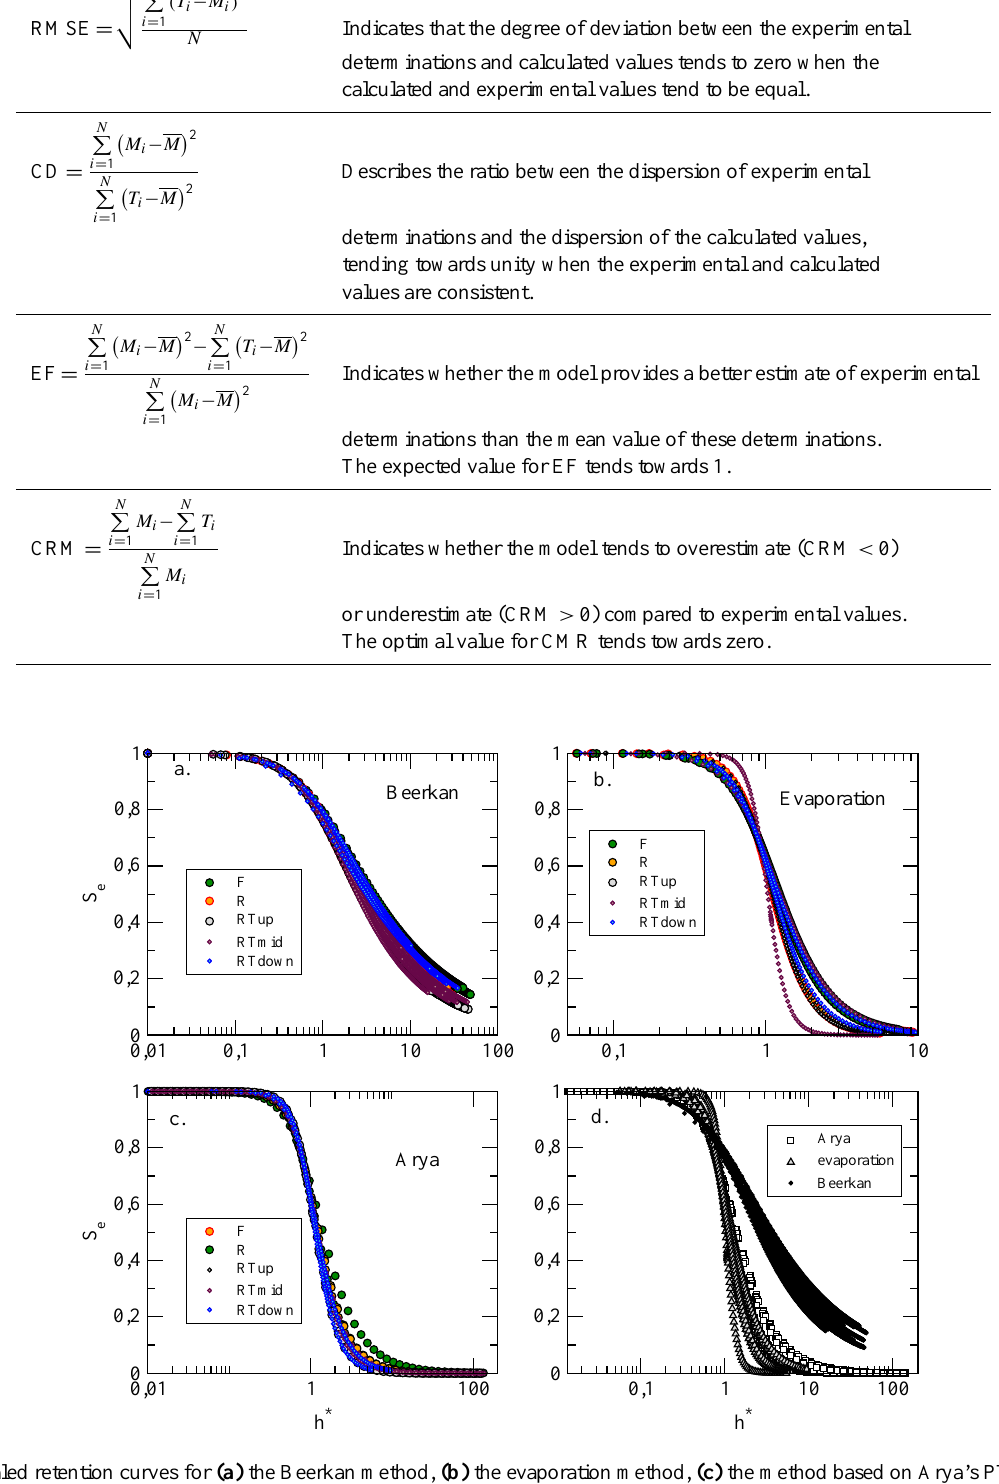
Figure 3. Scaled retention curves for (a) the Beerkan method, (b) the evaporation method, (c) the method based on Arya’s PTF, and (d) the different